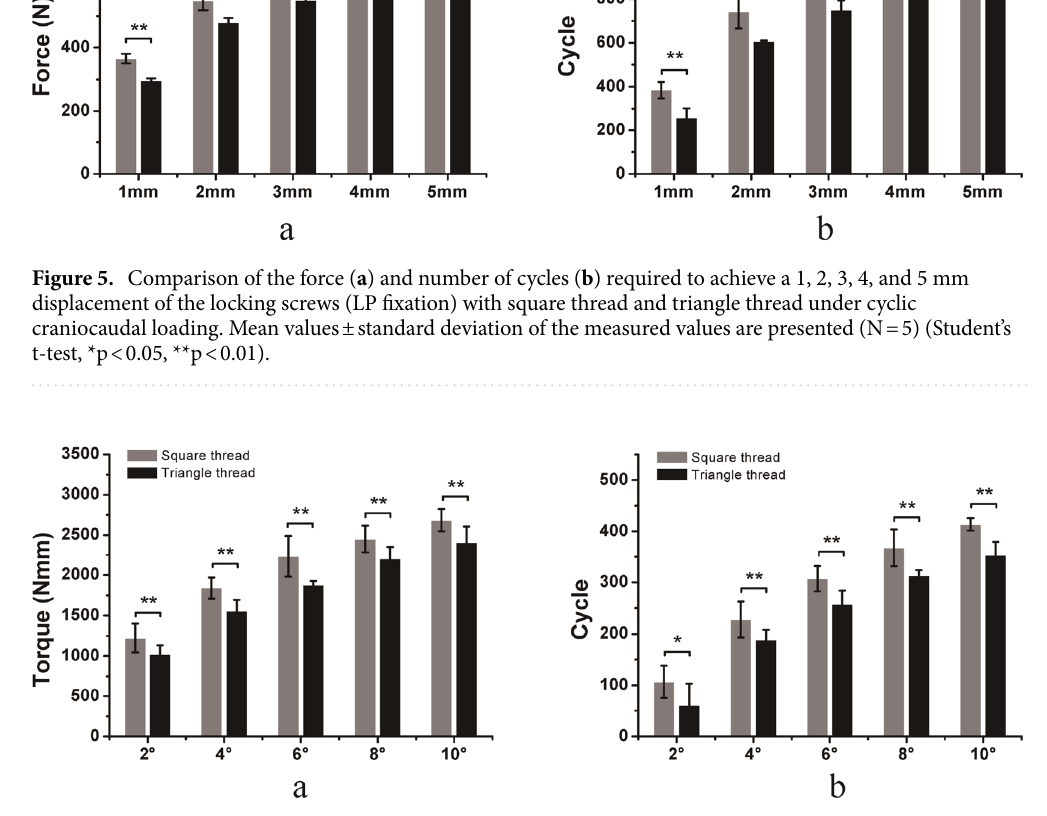
Figure 6. Comparison of torque ( a ) and number of cycles ( b ) required to achieve 2, 4, 6, 8, and 10 degrees of torsion of the locking screws (LP fixation) with square threads and triangle threads under cyclic torsional loading. Mean values ± standard deviation of the measured values are presented (N = 5) (Student’s t-test, *p < 0.05, **p <